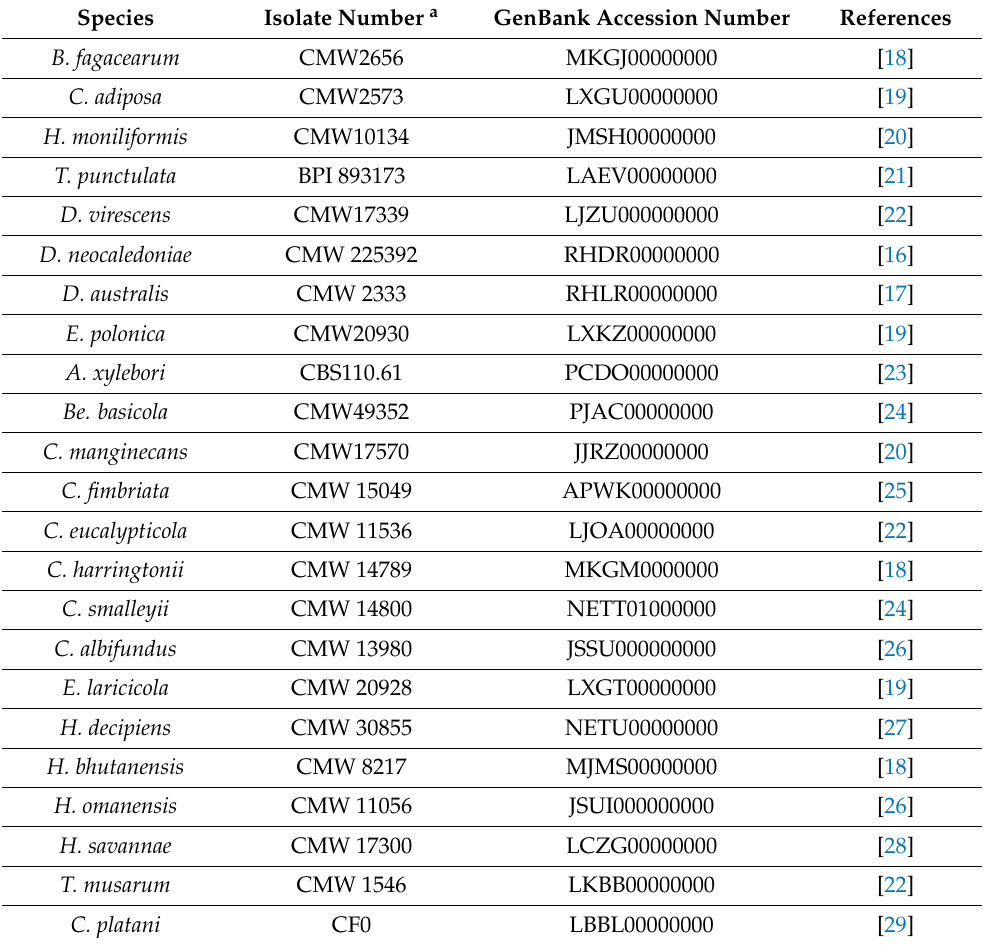
Table 1. Isolates numbers and genome sequence information for the species used in this study. Species Isolate Number